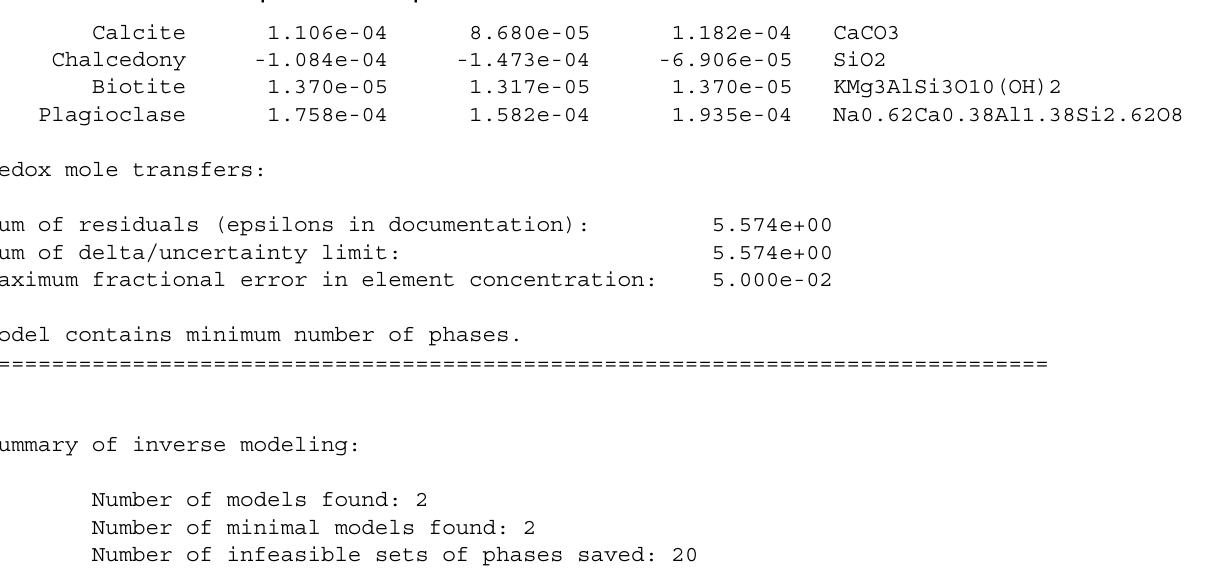
Table 48. Selected output for example